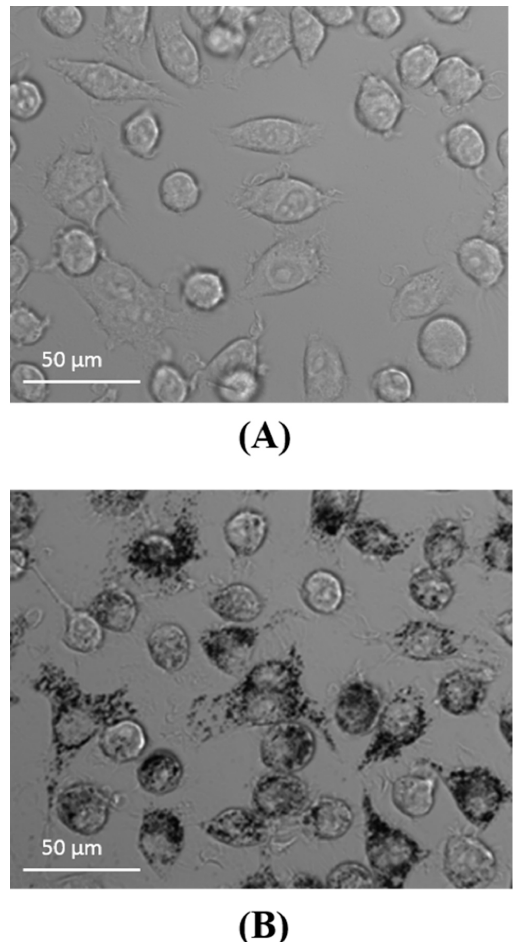
Figure 3. AgNP uptake by BV-2 cells. ( A ) Control cells. ( B ) The cells incubated with AgNP for 2 h, Figure 3. AgNPs uptake by BV ‐ 2 cells. ( A ) Control cells. ( B ) The cells incubated with AgNPs for 2 h, light microscopy image, magnification 40 × . AgNP are visible as black points. light microscopy image, magnification 40×. AgNPs are visible as black points.